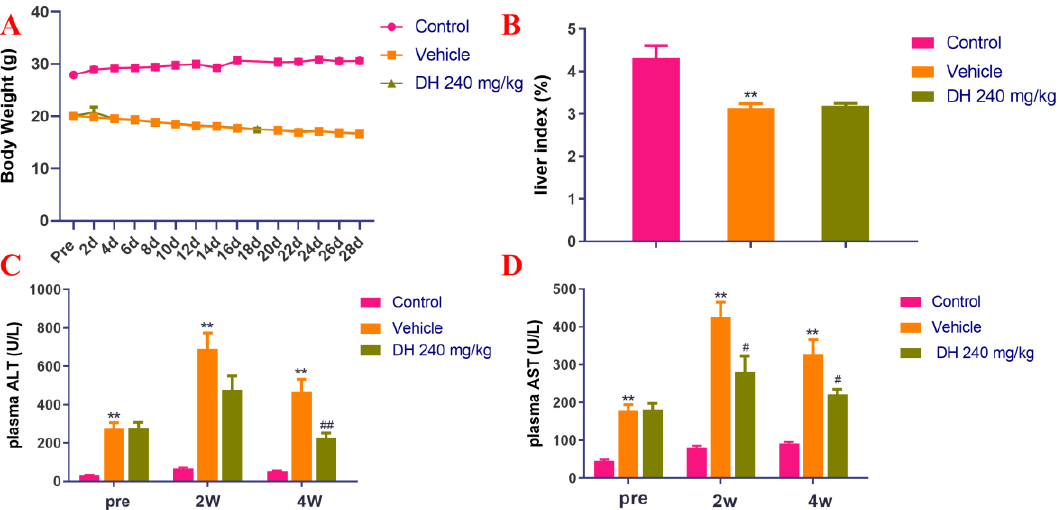
Figure 1. Investigation of the blood plasma concentrations of ALT and AST in NASH mouse model after supplementation of mice with ethyl acetate extraction of D. heterophyllum . Body weight ( A ), liver index ( B ), plasma levels of ALT ( C ) and AST ( D ). Pre: preparation; 2 d – 28 d: 2 days – 28 days; 2W: 2 weeks, 4W: 4 weeks. DH 240 mg/kg: 240 mg/kg ethyl acetate extract. Values are presented as the mean ± SD ( n = 10). ** p < 0.01 vs. the control group; # p < 0.05, ## p < 0.01 vs. the vehicle group.